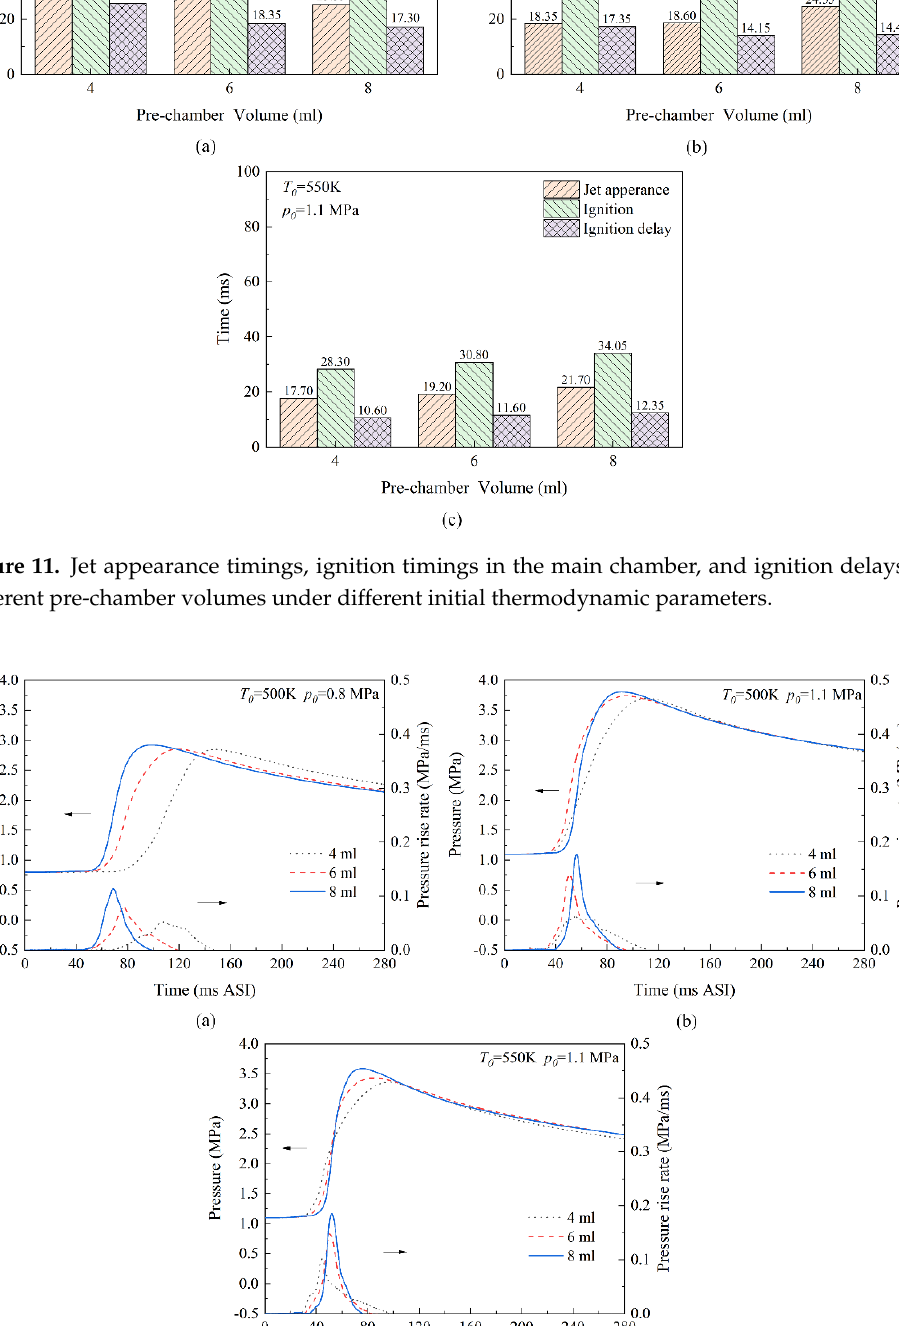
Figure 12. Pressure and pressure rise rate traces in the main chamber for different pre-chamber volumes under different initial thermodynamic parameters.